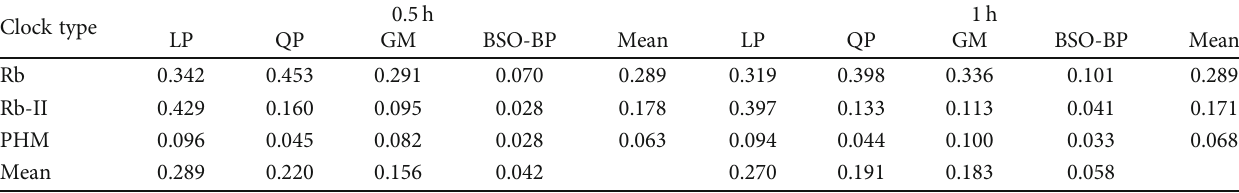
Figure 11: The residual plot of three satellites using 12 hours data to forecast 1 hour: (a) the residual value of C01 forecast 1 hour; (b) the residual value of C23 forecast 1 hour; (c) the residual value of C27 forecast 1 hour. Table 2: The average prediction accuracy for 0.5 hours and 1 hour for three di ff erent types of clocks based on 6-hour SCB data.